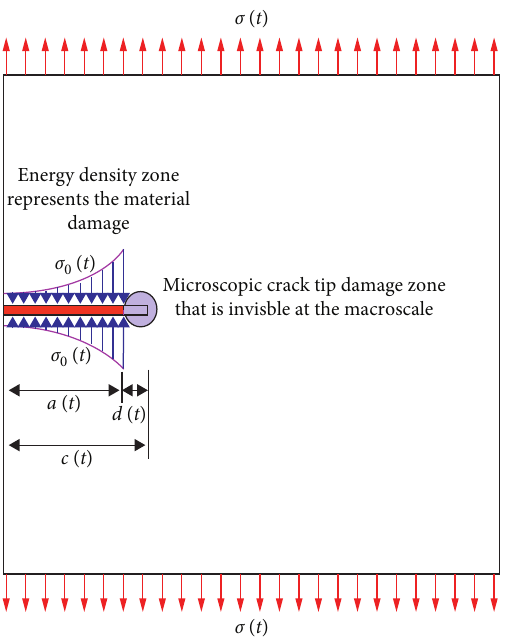
Figure 8: Energy density zone model to depict the scale transition of fracture process under the static